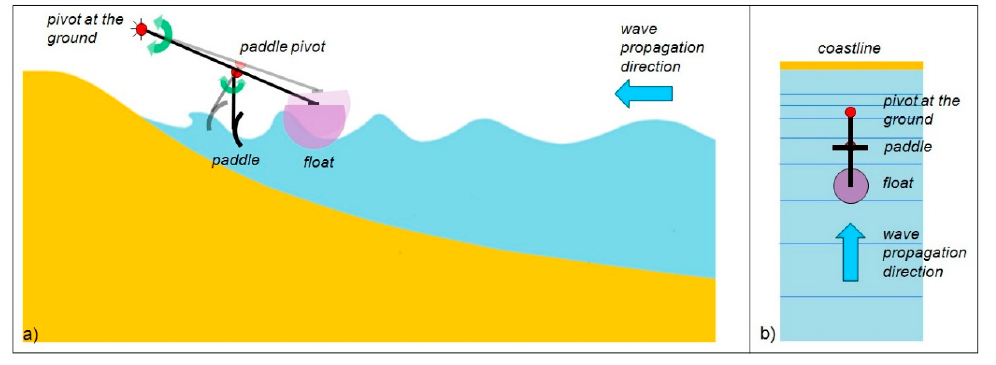
Figure 1. EDS concept. ( a ) side view; ( b ) top view.